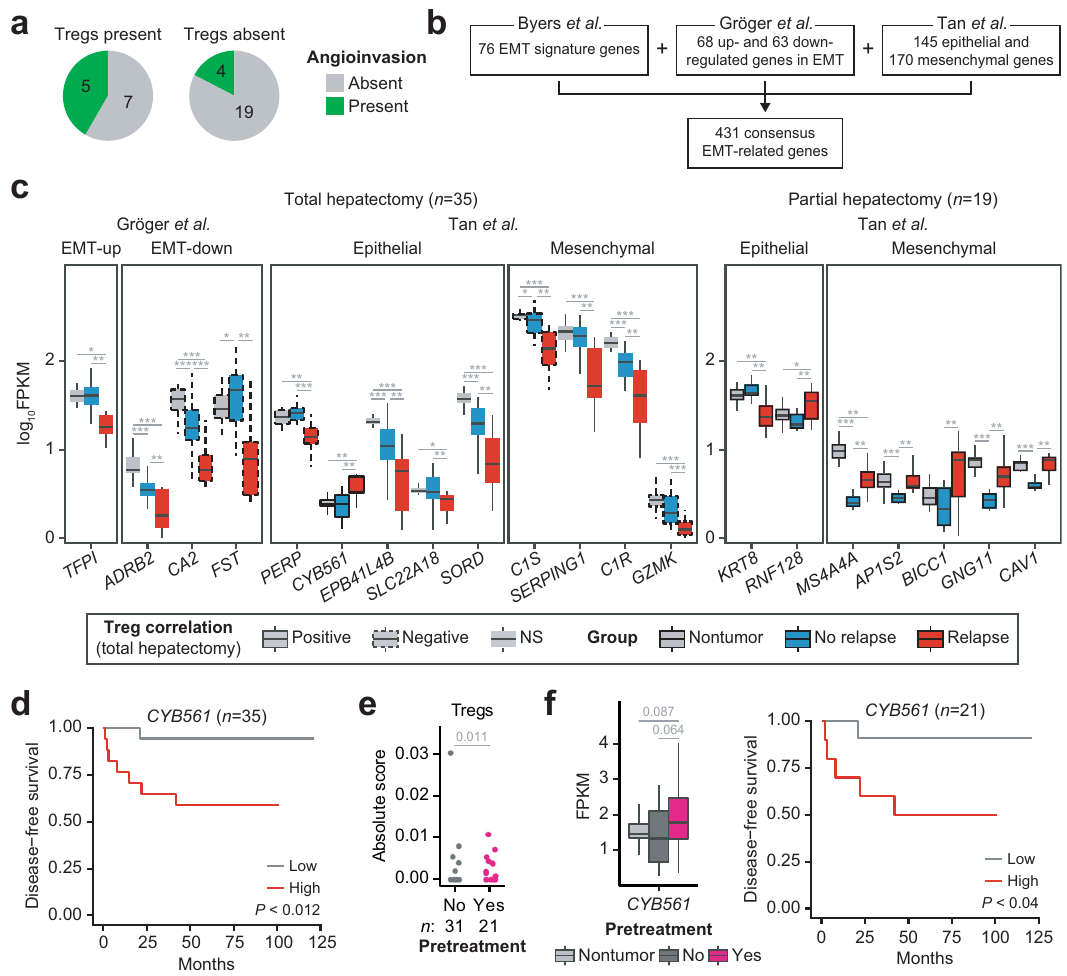
Fig. 5 Clinical relevance of pretreatment in the total hepatectomy group. a Angioinvasion and Treg in fi ltration in the TH group. b 431 EMT markers pooled from three independent studies. c Dysregulated EMT marker expression upon tumor relapse in the TH (left, n = 35) and PH (right, n = 19) groups. The correlation with Tregs was examined only in the TH group. Epithelial = highly expressed in epithelial cells, mesenchymal = highly expressed in mesenchymal cells, EMT-up/down = up-/down-regulated expression, respectively, during EMT. Each group is indicated as a colored box (gray for nontumor, blue for no relapse, and red for relapse), and the Treg correlation of the TH group is indicated by the outline (solid for positive, dotted for negative, and no line for no correlation). d Kaplan – Meier survival analysis for patients strati fi ed by high and low CYB561 expression in the TH group. e Absolute score of Tregs upon pretreatment in the Korean HCC cohort ( n = 52). Two samples with missing pretreatment information were excluded. P value was estimated using the One-sided Barnard ’ s test. f Dysregulation of CYB561 expression upon pretreatment and Kaplan – Meier survival analysis of the pretreatment subgroup. P values (left) were estimated using the Welch ’ s t -test. For boxplots, the center line represents the median. The upper and lower limits of each box represent the 75th and 25th percentiles, respectively. The whiskers represent the highest and the lowest data points still within the 1.5× interquartile